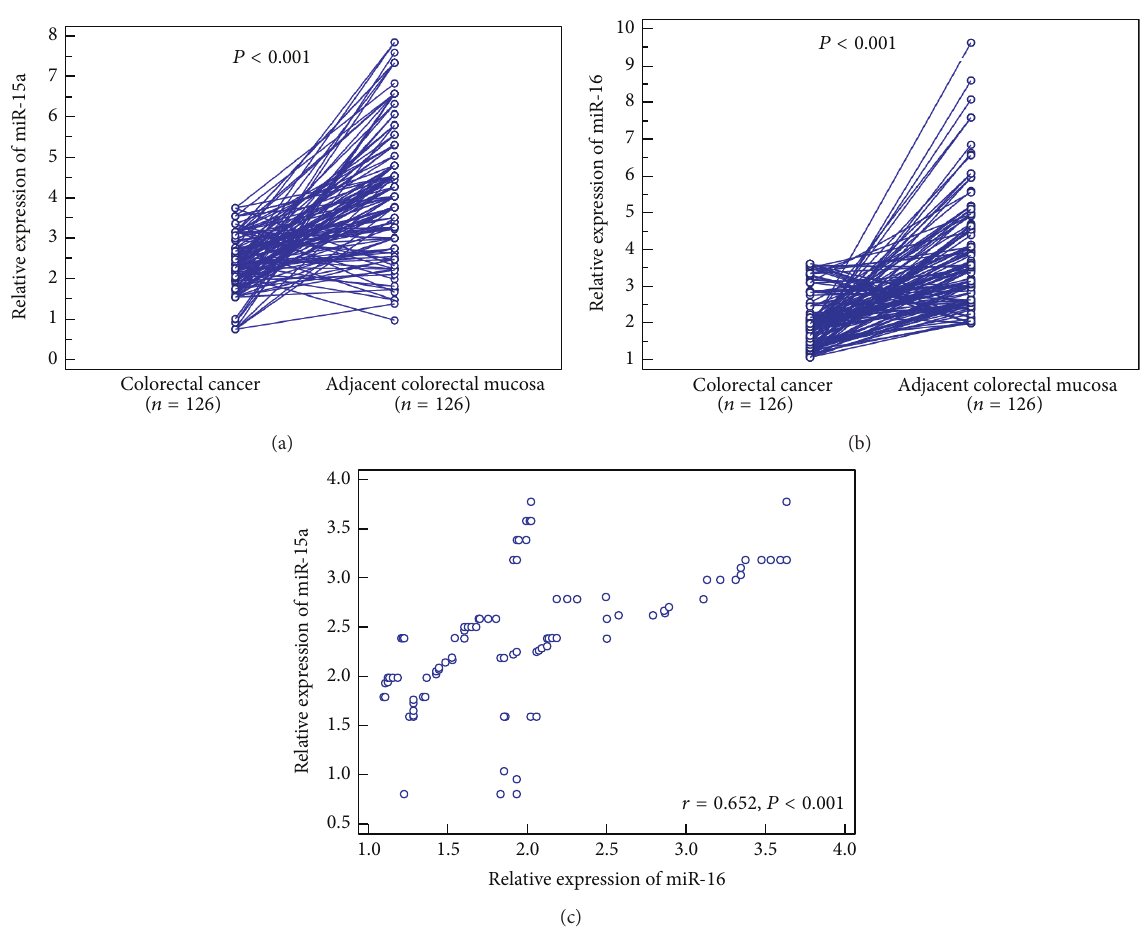
Figure 1: Relative expression levels of miR-15a (a) and miR-16 (b) in colorectal cancer tissues and adjacent colorectal mucosa. The expression levels of miR-15a in colorectal cancer tissues were positively correlated with those of miR-16 significantly (Spearman correlation coefficient 𝑟 = 0.652 , 𝑃 < 0.001 , (c)).